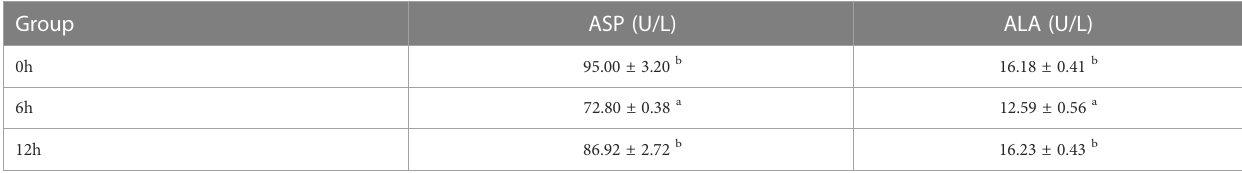
TABLE 3 Characteristics of serum ASP and ALA activities of pond-cultured Japanese fl ounder.